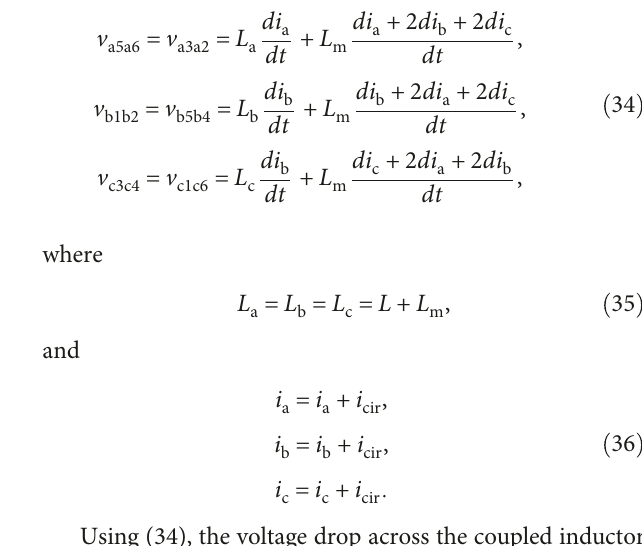
Figure 13. The HMC with one six-winding coupled inductor